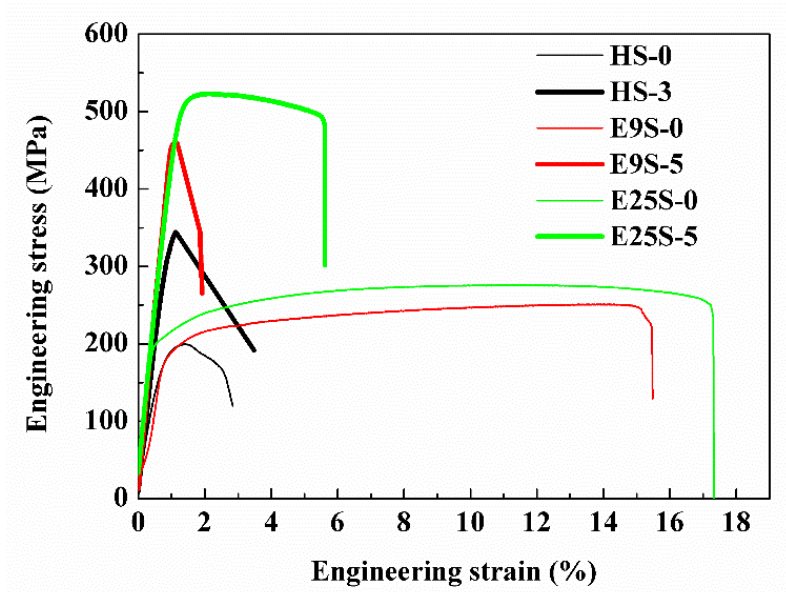
Figure 10. Room temperature tensile stress–strain curves of the as-homogenized, extruded, and swaged samples. Table 3. Lists of tensile yield strength (YS), ultimate tensile strength (UTS), and elongation to failure ( ε ef ) of the as-homogenized, extruded, and swaged samples.